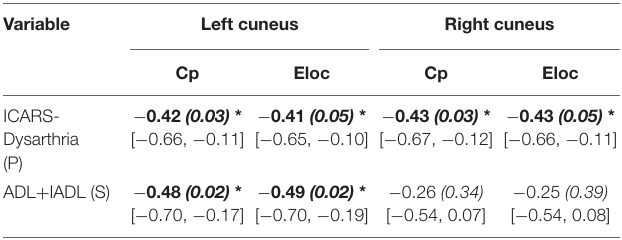
TABLE 3 | Correlations between regional neuroimaging attributions and clinical variables. Variable